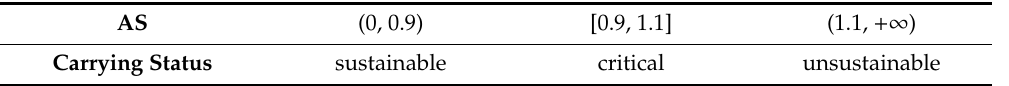
Table 2. Evaluation criteria for the status of the power supply and demand